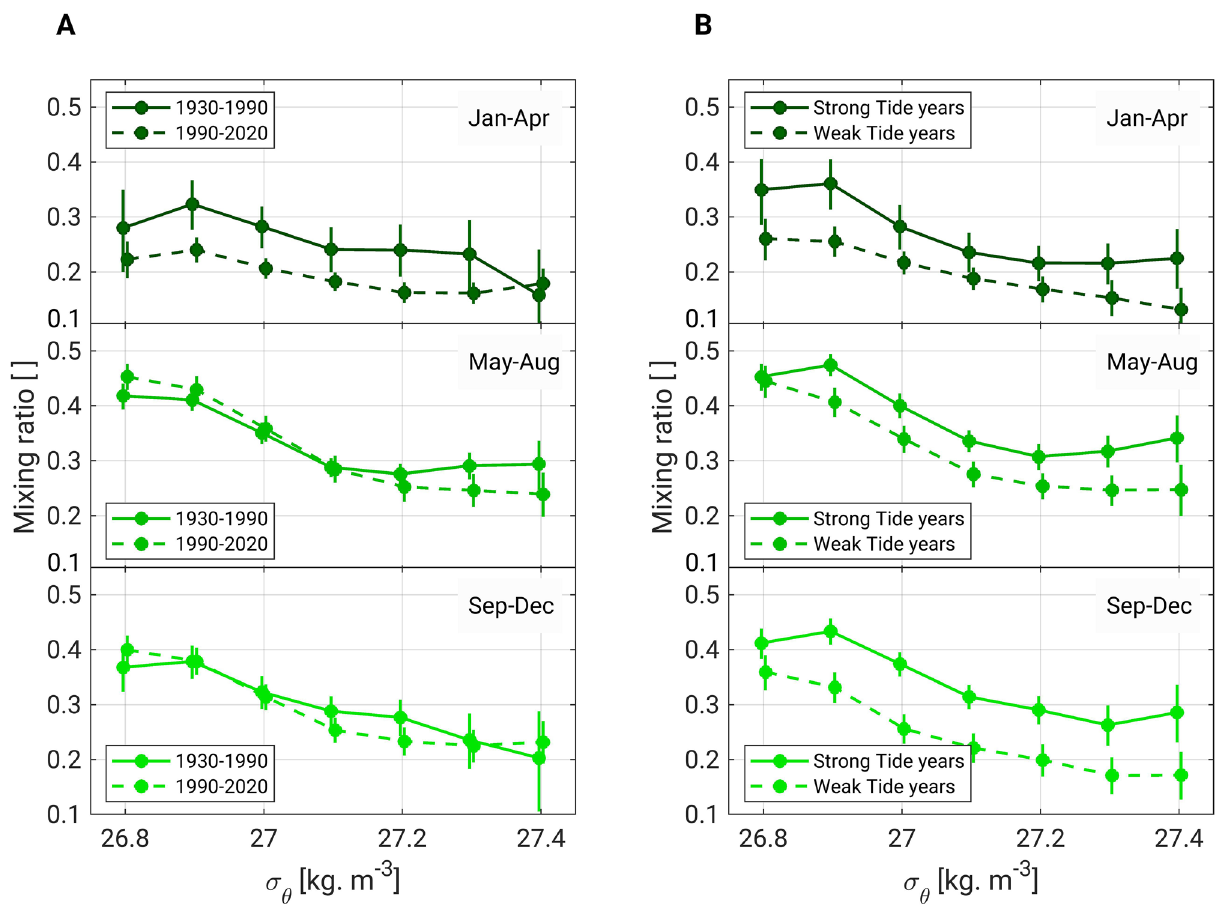
Figure 6. Seasonal mixing ratio in different climatological periods. ( A ) Mixing ratio averages for 1930–1990 and for 1990–2020 in winter (top), summer (middle), and fall (bottom). ( B ) Same as ( A ) for the mixing ratio averaged over strong and weak diurnal tide years. The error bars represent the 95% confidence interval (see “Methods” for details on the confidence interval and mixing ratio calculations). The data points and corresponding error bars are slightly shifted horizontally for